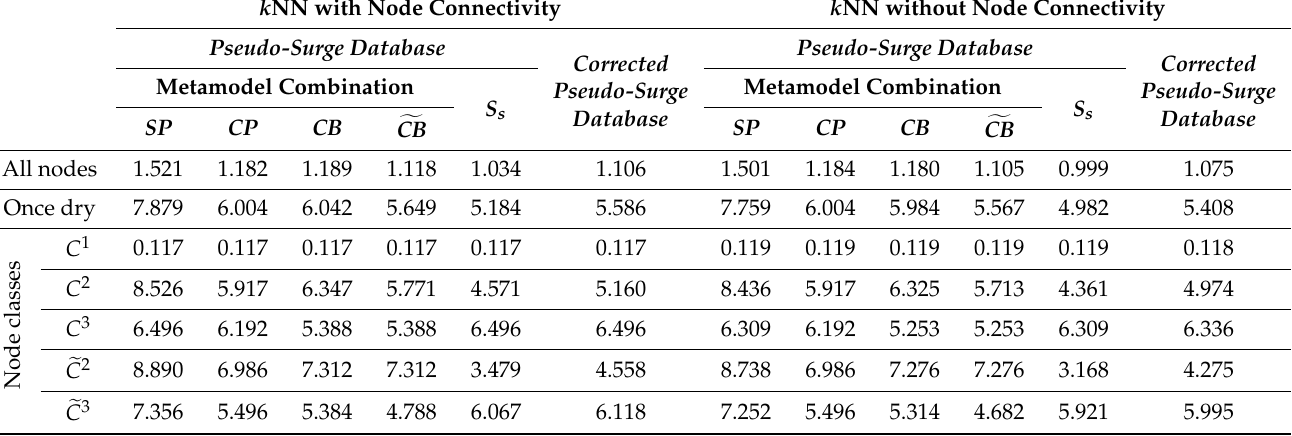
Table 10. False-negative misclassification ( − MC ) percentage for different variants and different groups of nodes for different surrogate model variants for the implementation that considers different surge metamodels for different classes of